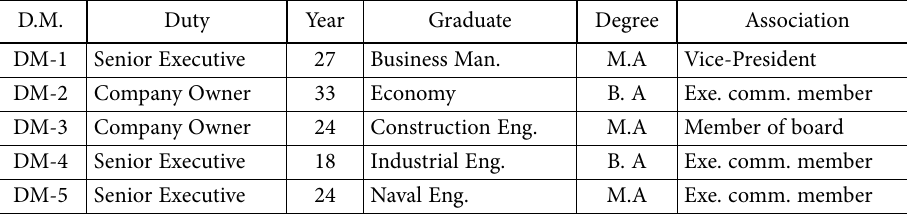
Table 1. The board of experts and their details